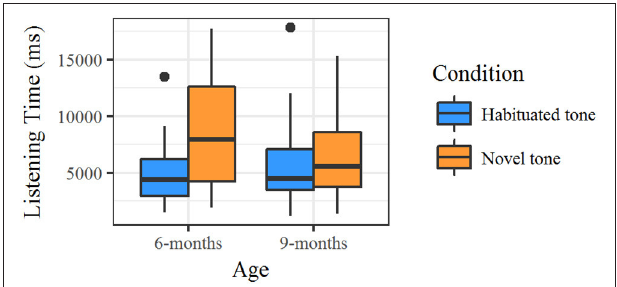
FIGURE 4 | Results from the habituation experiment divided by age group. Mean listening times to the novel tone were significantly longer compared to those to the habituated